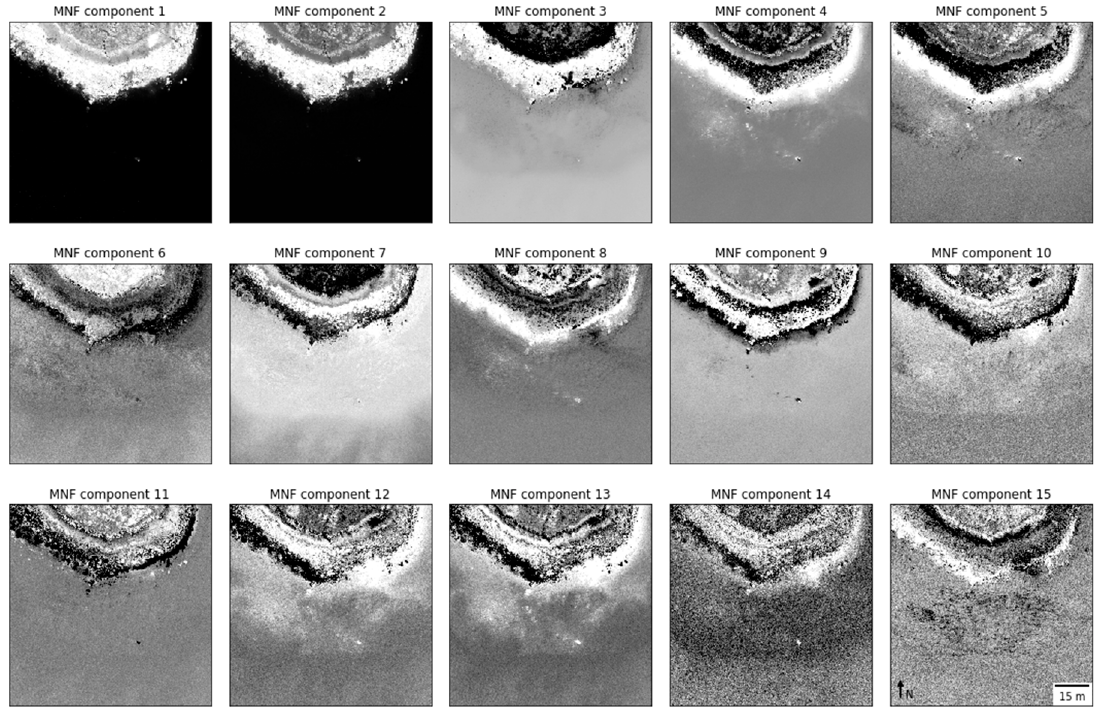
Figure 7. Minimum noise fraction (MNF) components 1–15 (signal-to-noise ratio ≥ 5) calculated from surface reflectance.